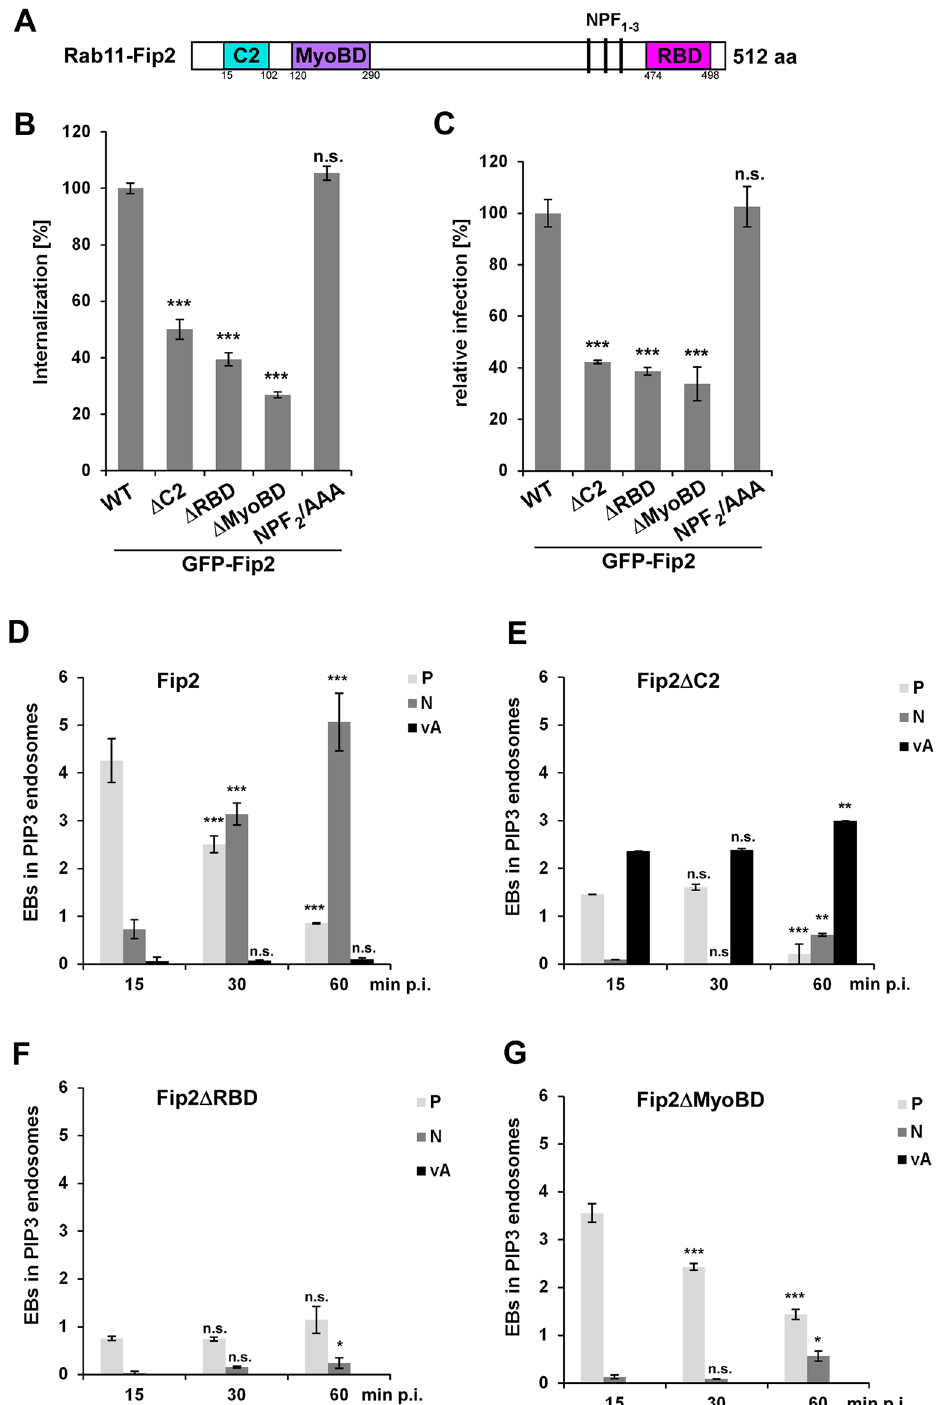
Fig 5. The Rab11-binding domain of Fip2 is essential for C . pneumoniae infection. (A) Schematic representation of Fip2. (B, C) Quantification of EB internalization (B) or chlamydial infection (C) in HEp-2 cells stably expressingthe indicatedGFP-Fip2 mutant variants. (B) Analysis of C . pneumoniae EB internalization at 2 hpi in 30 individual cells (n = 3). (C) Quantification of infection basedon the numbers of inclusionsfound in 40 visual fields at 48 hpi (n = 4). (D-G) Colocalization analysisof EBs in PI3P-positiveendosomes(visualized with mCherry-2xFYVE and DAPI) in HEp-2 cells stably expressingGFP-Fip2 mutant variants at 15 min to 60